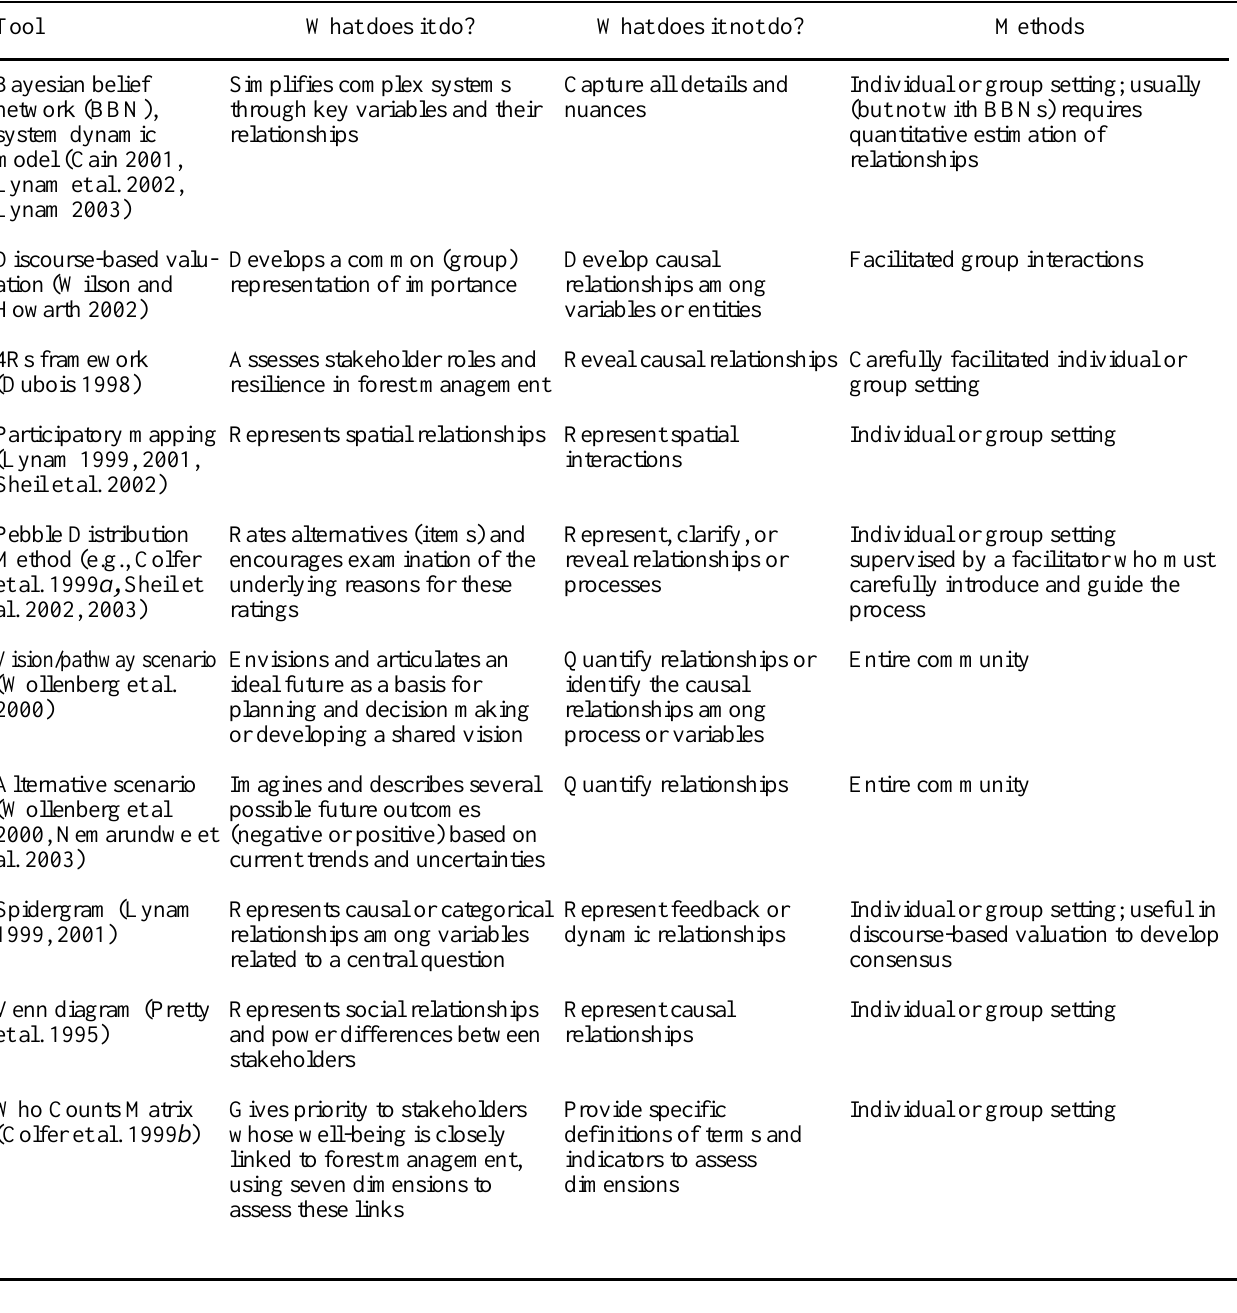
Table 1 . Evaluation criteria applied to each of the tools reviewed: